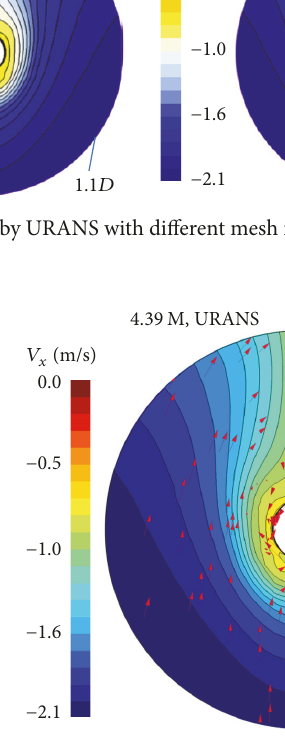
Figure 11: Predicted axial, tangential, and radial velocity at the propeller plane by URANS and